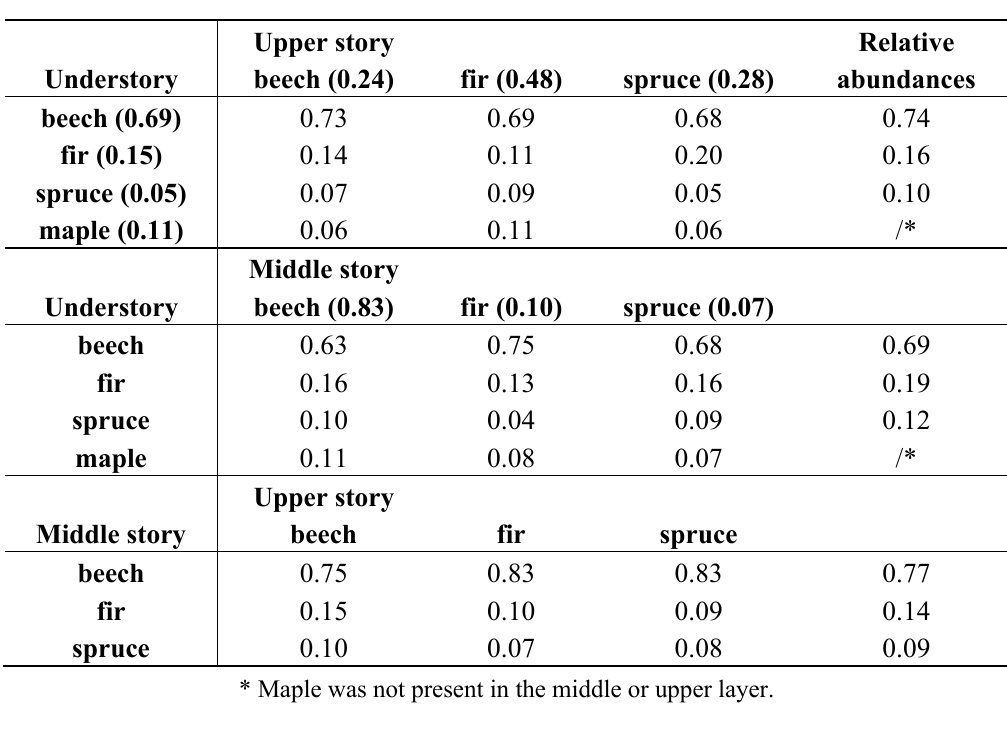
Figure 3. Change in tree species composition according to tree density ( above ) and basal area ( below ) in the last six decades. Three, two and one stars denote a significance code of p < 0.05, p < 0.01 and p < 0.001,